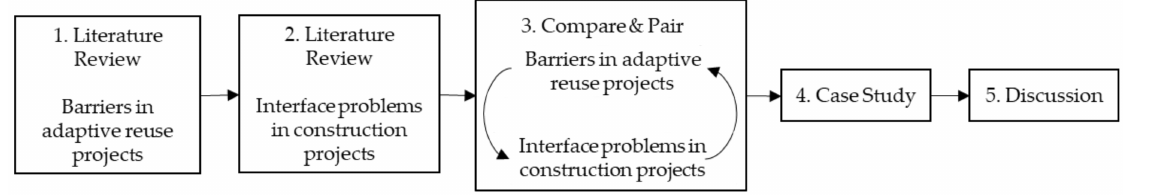
Figure 2. The methodology steps of this